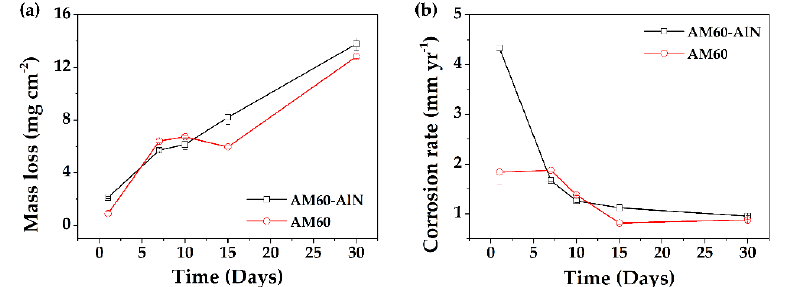
Figure 4. Changes in time of ( a ) mass loss and ( b ) annual corrosion rates of AM60-AlN and AM60 after exposure to SME solution up to 30 days.